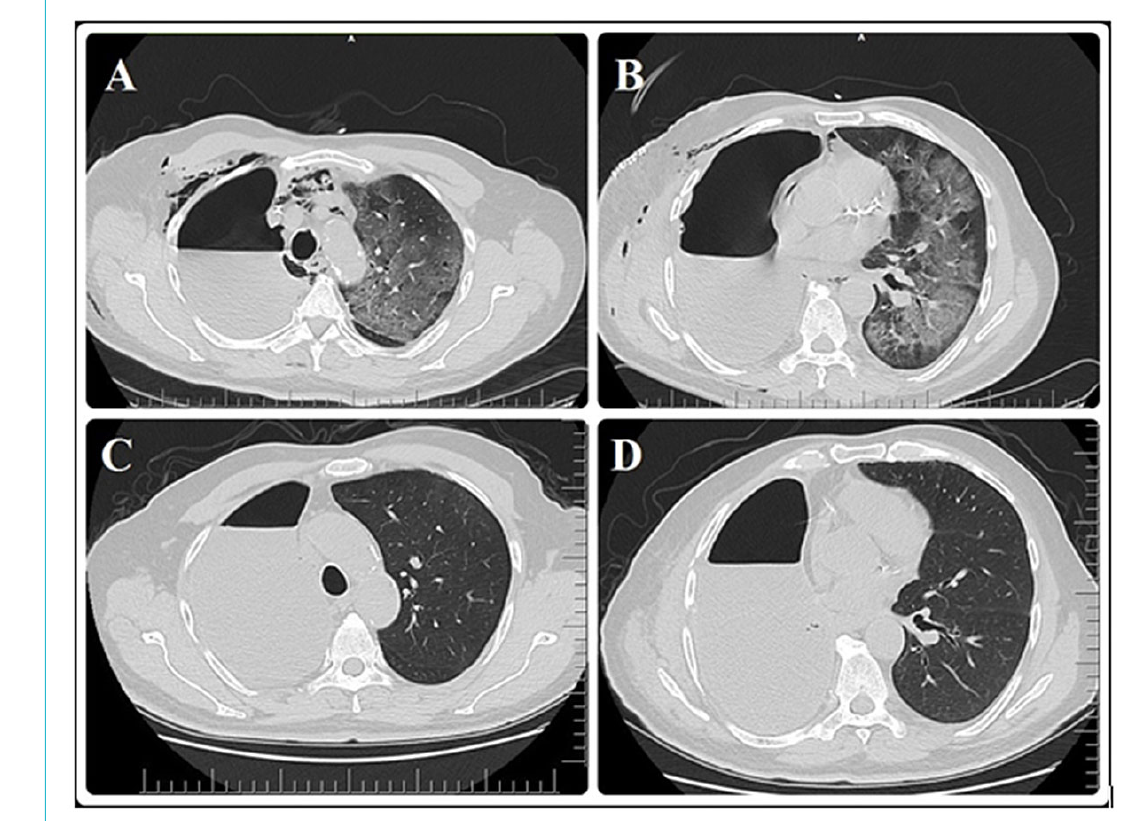
Figure 2: ( A,B) Postoperative day 4, images of HRCT from different cross-sectional levels taken after fever. Alveolar opacity, vascular conges- tion and inter-septal thickening areas in diffuse ground glass density in both lobes of left lung. (C,D) Control HRCT images taken on discharge (17th) day. It was observed that the ground glass opacity in both lobes of the left lung has recovered almost